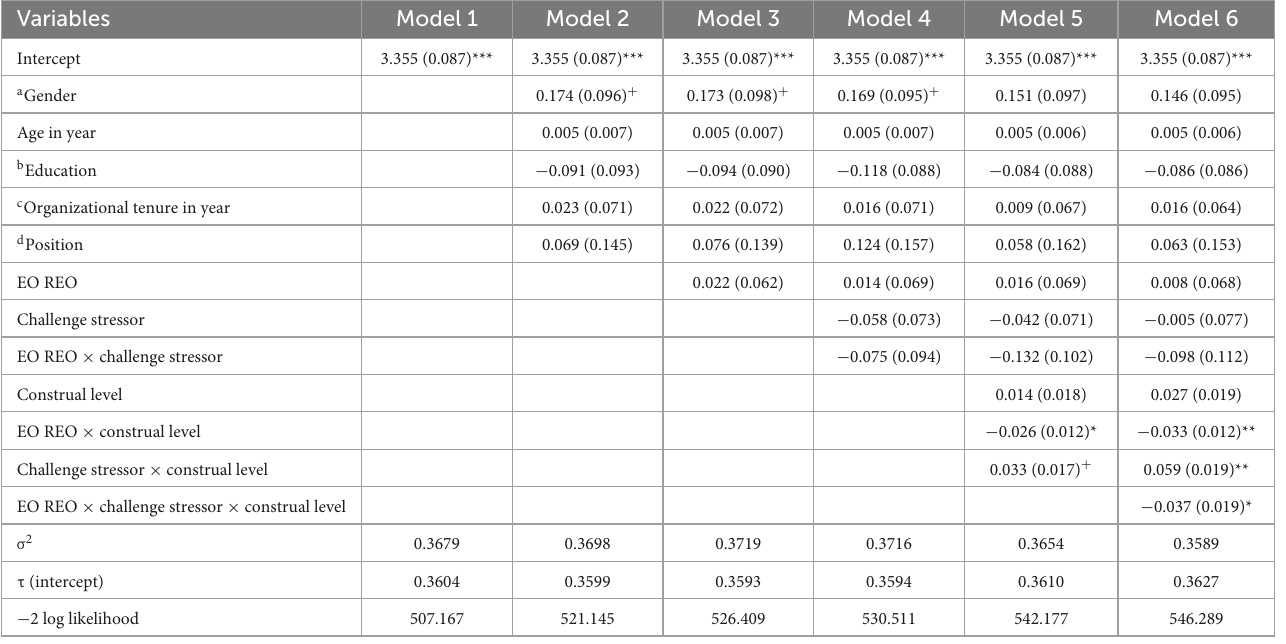
TABLE 4 The results of hierarchical linear model in study